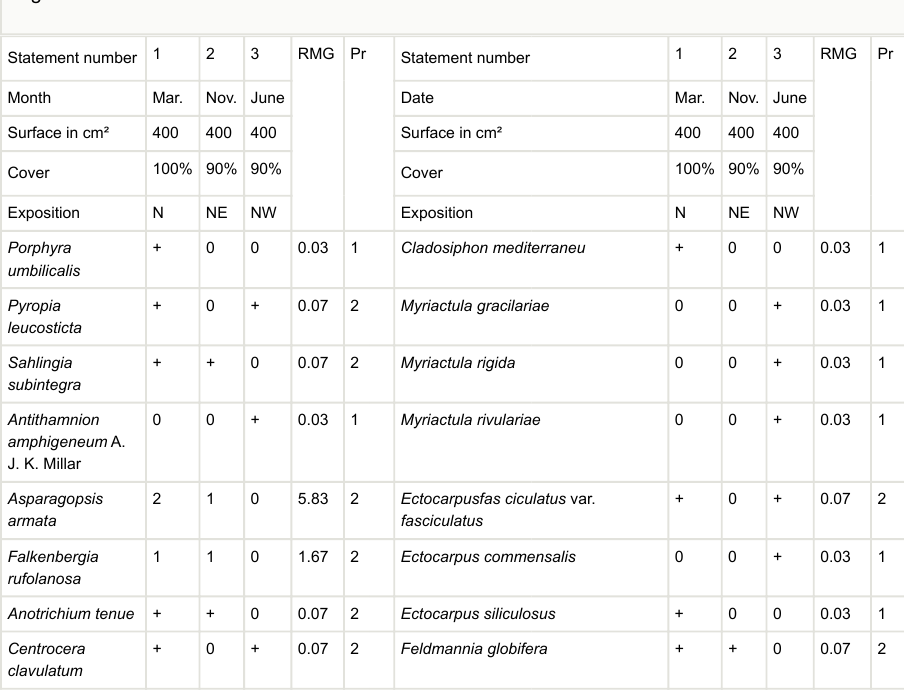
Algal settlement sheet: Small Port